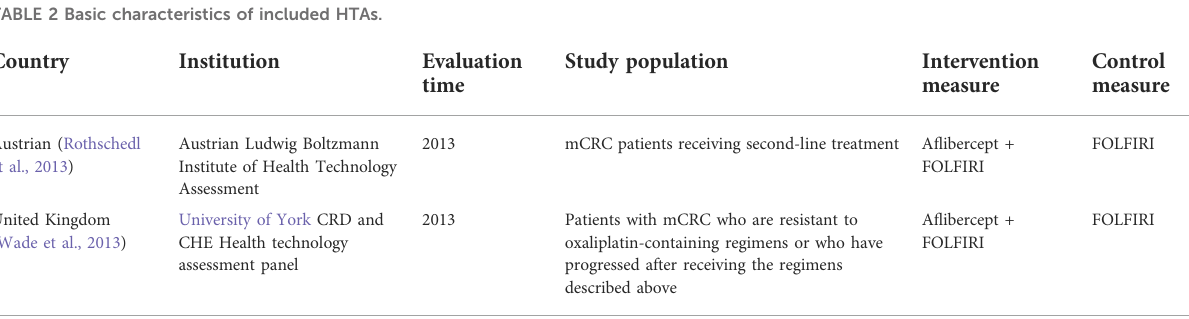
TABLE 2 Basic characteristics of included HTAs.